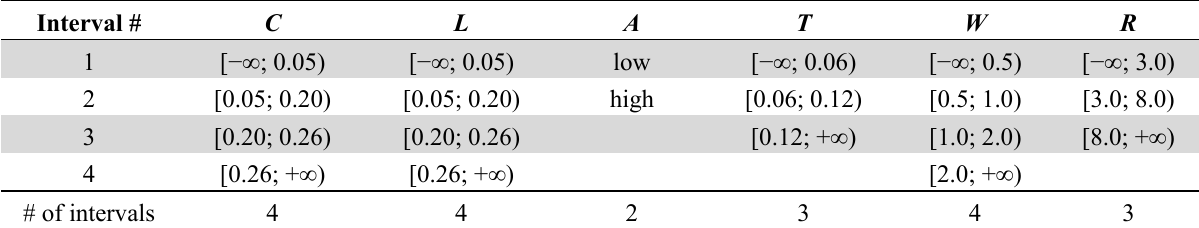
Table 2. Summary of the intervals limits defined for each of the six context variables, described in Table 1.